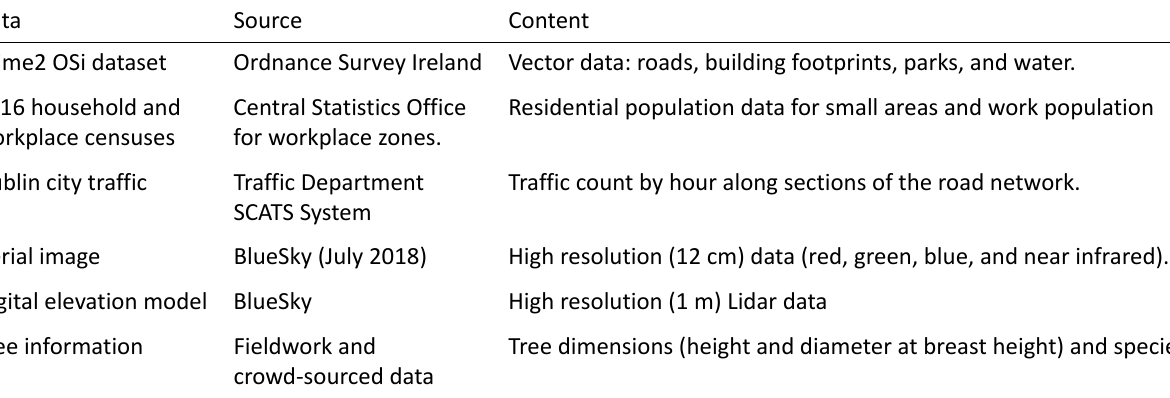
Table 1. A list of the main sources of information used in the MGD